Question: Briefly state, in one sentence, what is plotted here.
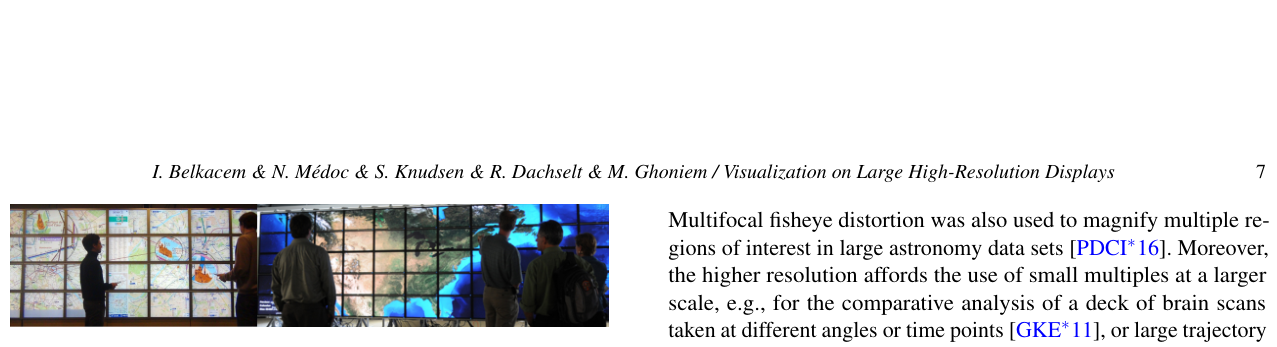
Answer: Geographical data visualization. (left) Users control a magniﬁcation lens on a map using mobile devices [CBF14]; (right) users collaborate on exploring a large map [WPH10].